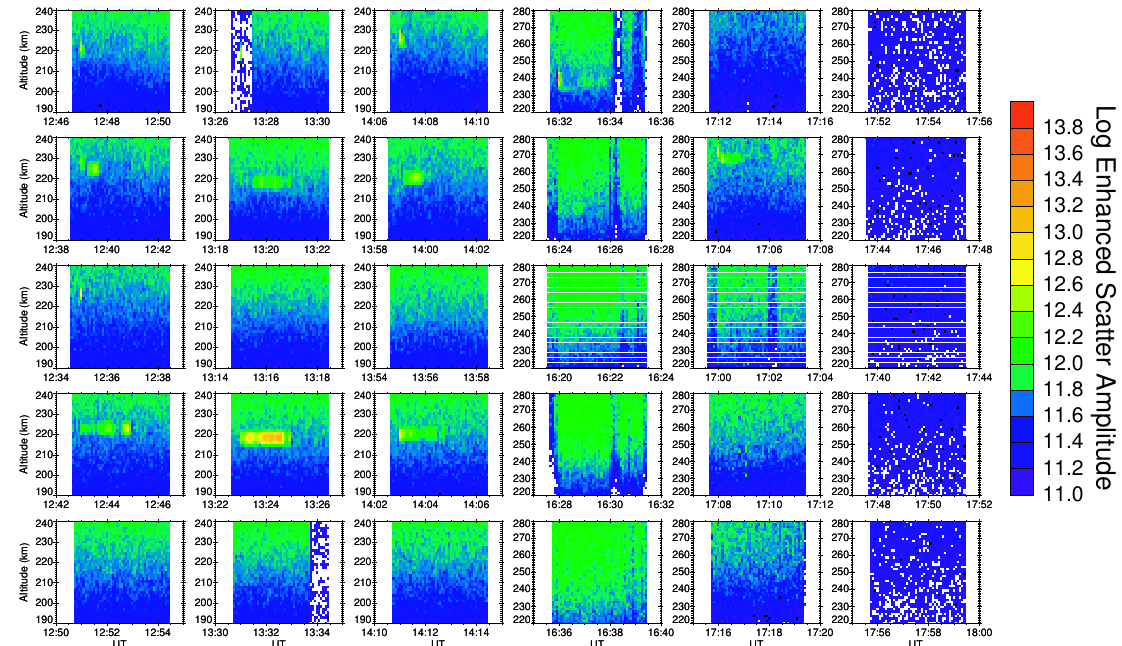
Heater = V and UHF = FA+12, FA+6, FA, FA-6 and FA-12: 26/9/2002